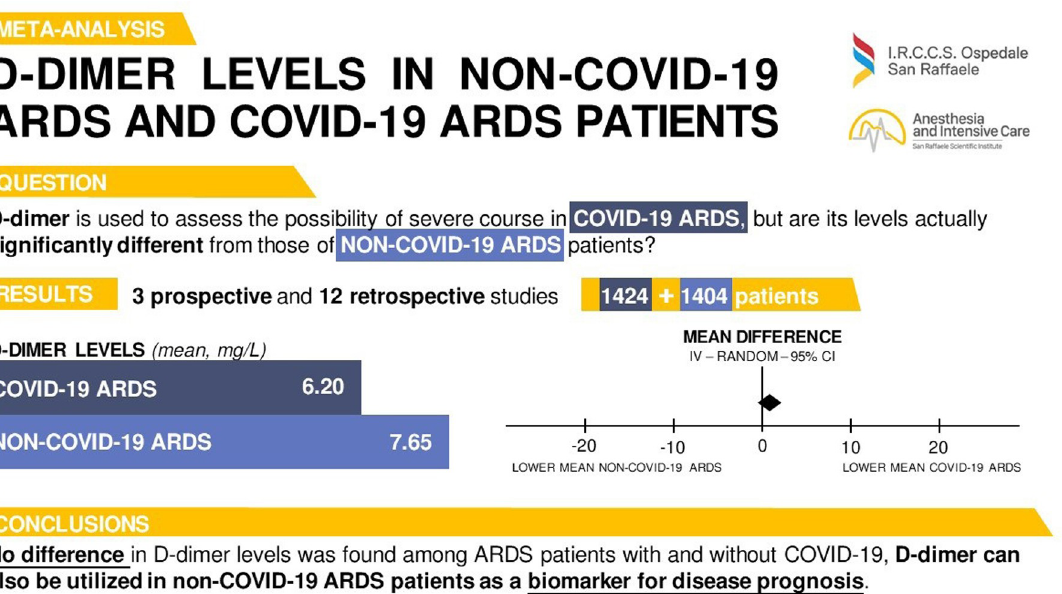
Fig 2. D-dimer levels in non-COVID-19 ARDS and COVID-19 ARDS patients. Visual summary of the main steps of our research. The non-COVID-19 ARDS patients had statistically lower fibrinogen levels (mean 454 mg/ dl vs. 653 mg/dl) [12–15, 18–21, 25, 26] when compared to COVID-19 ARDS patients result- ing in a MD of -173 mg/dl (95% CI: -232.48 to -113.63) p < 0.001 (S3 Fig in S1 File). In contrast, CRP levels [13–15, 18, 20–23] (MD -1.07 mg/dl [95% CI: -5.08 to 2.95, p = 0.60]) and PaO2/ FiO2 ratio [12, 13, 17–25] (MD -2.75 mmHg [95% CI: -10.15 to 4.65, p = 0.47]) were similar between groups (S2 and S4 Figs in S1 File). COVID-19 mean 16.0 days vs. COVID-19 mean 17.8 days) [12, 15, 17, 19, 22–24, 26] and